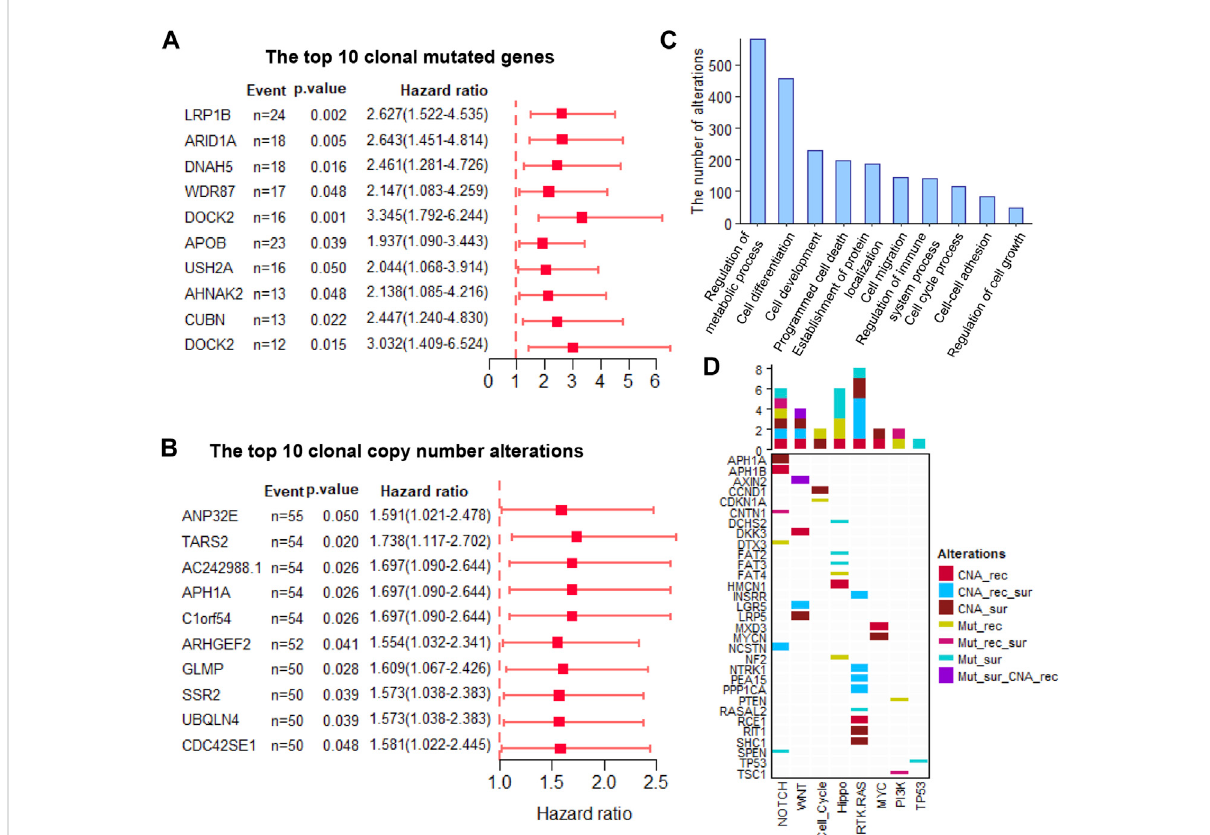
FIGURE 2 The prognosis-related clonal altered genes (A) . The prognosis potential of the top 10 clonal altered somatic mutations (B) . The prognosis potential of the top 10 clonal altered CNAs (C) . Gene Ontology analysis of clonal altered genes (D) . The clonal altered genes involved in oncogenic pathways. CNA_rec, the clonal altered CNAs that related to recurrence; CAN_sur, the clonal altered CNAs that related to survival; CAN_rec_sur, the clonal altered CNAs that both related to recurrence and survival; Mut_rec, the clonal altered somatic mutations that related to recurrence; Mut_sur, the clonal altered somatic mutations that related to survival; Mut_rec_sur, the clonal altered somatic mutations that both related to recurrence and survival; Mut_sur_CNA_rec, the clonal altered somatic mutations and CNAs that related to survival and recurrence,